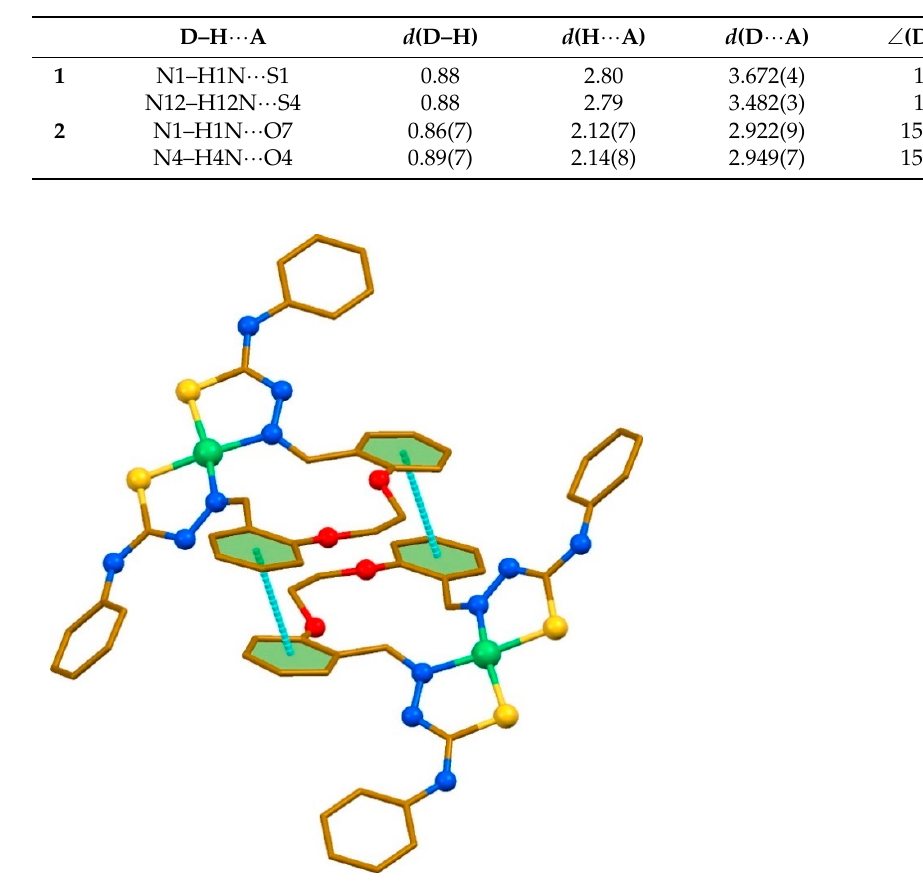
Figure 2. A dimer, formed by π ∙∙∙ π stacking interactions between two molecules 1-I in the crystal structure of 1 (hydrogen atoms are omitted for clarity). Color code: C = gold, H = black, N = blue, O = red, S = yellow, Ni = green; π ∙∙∙ π stacking interaction = cyan dashed line.